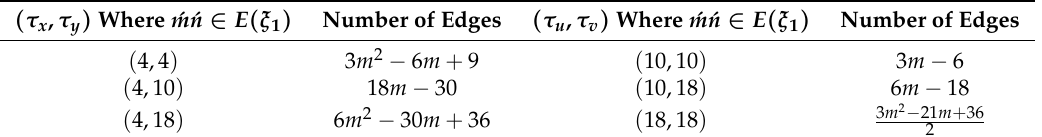
Table 3. Edge partition of the third type of triangular hex-derived network THDN 3 ( m ) based on degrees of end vertices of each